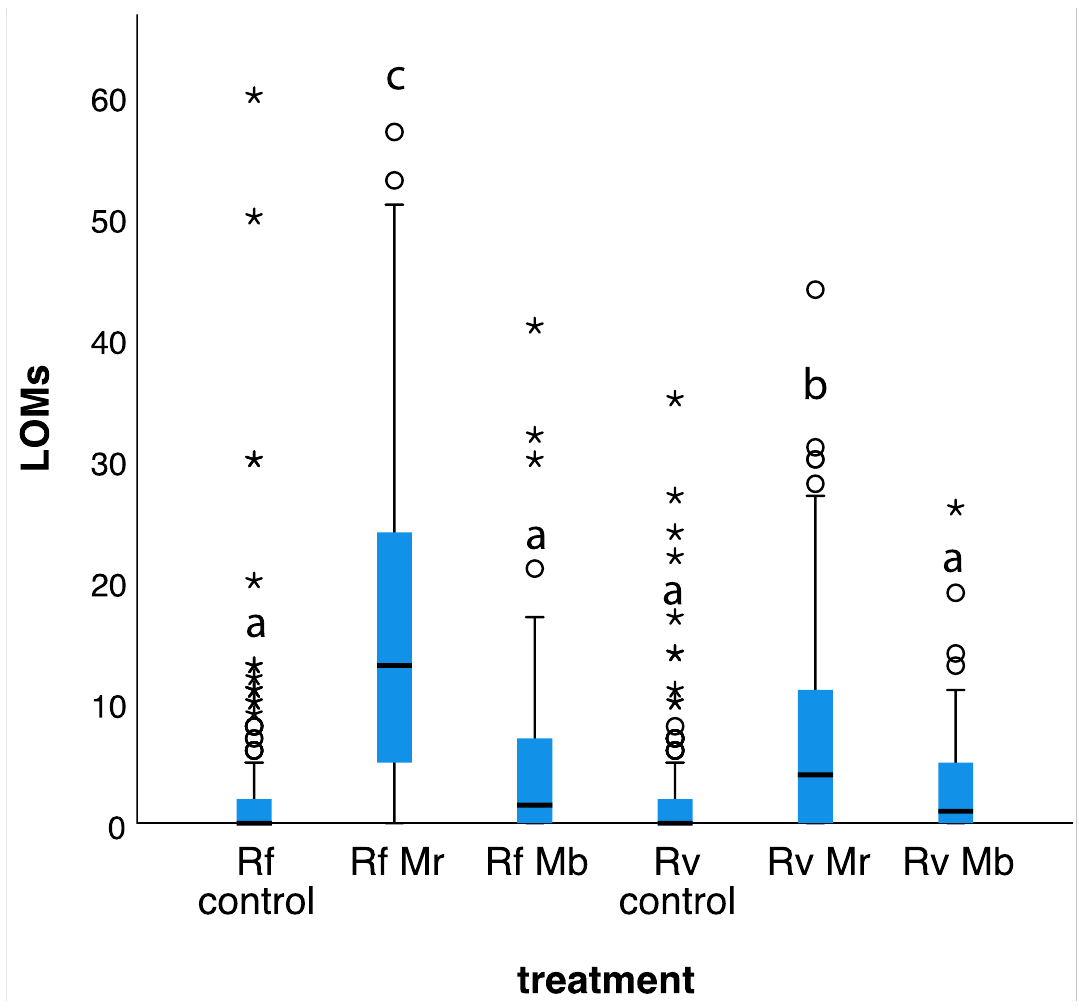
Figure 2. Alarm response to fungal challenge. Boxplots represent the distribution of LOMs (LOMs scored in 709 paint-marked individuals). Boxes correspond with the distance between upper and lower quartiles from the median (IQR). Whiskers correspond with 1.5 × IQR. Circles and asterisks depict outliers beyond 1.5 × IQR or 3 × IQR, respectively. Different letters indicate significant differ- ences between distributions for fungal and control treatments (Bonferroni adjusted). Rf corresponds